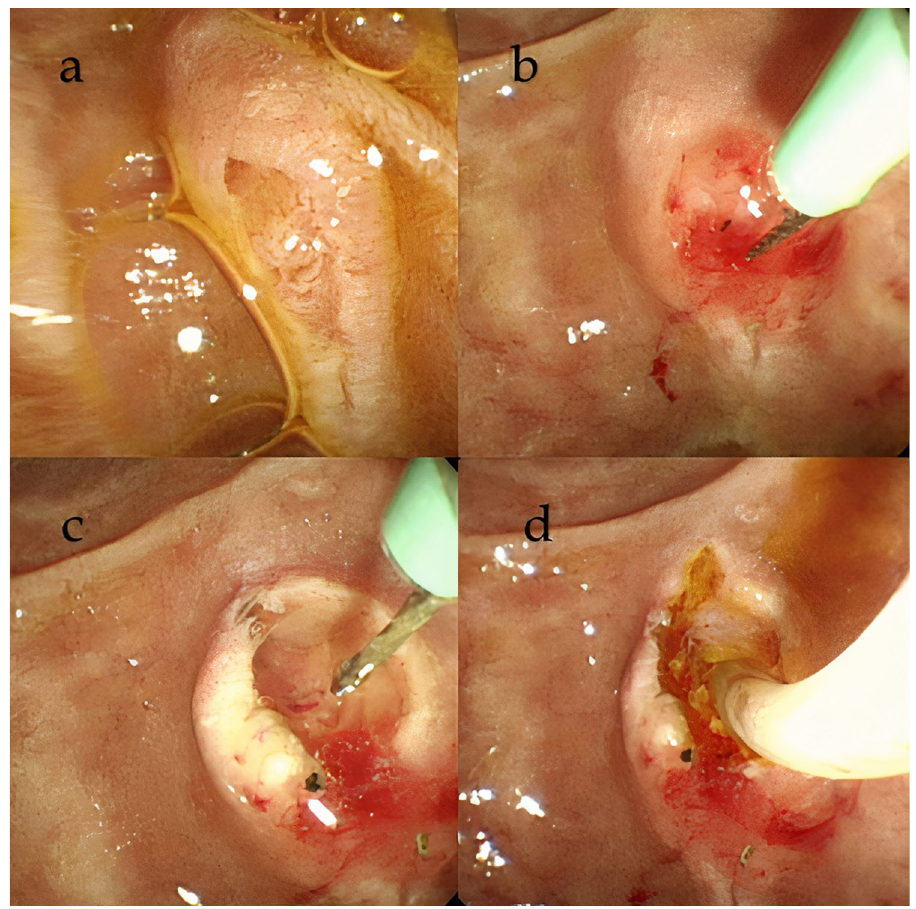
Figure 1. Needle-knife pre-cut papillotomy. ( a ) Original major papilla. ( b ) The incision is made upward along the axis of the bile duct from the papillary orifice. ( c ) The overlying mucosa is incised, and the bile duct is exposed. ( d ) Successful biliary cannulation is achieved.